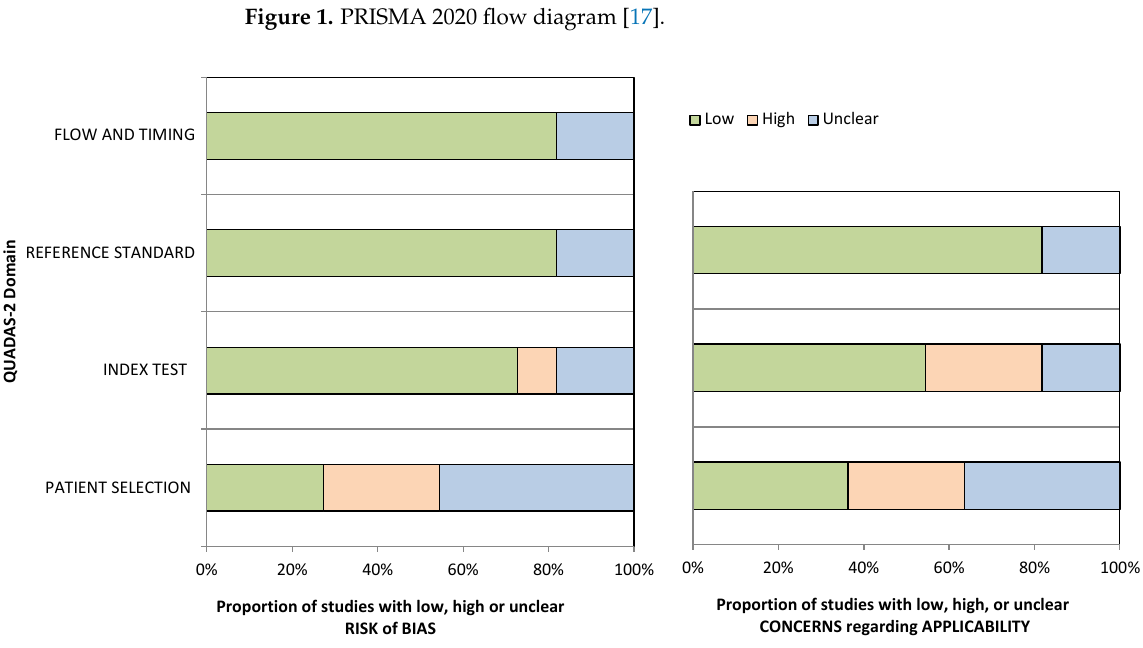
Figure 1. PRISMA 2020 flow diagram [17] .